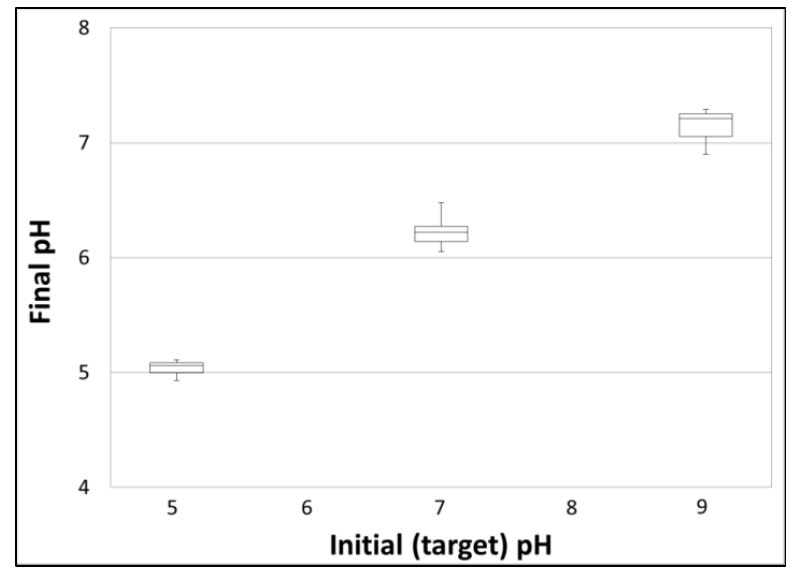
Figure 4. Box-and-whisker plots (min/max, lower/upper quartiles, and median) of the final treatment pHs for each initial target pH tested.